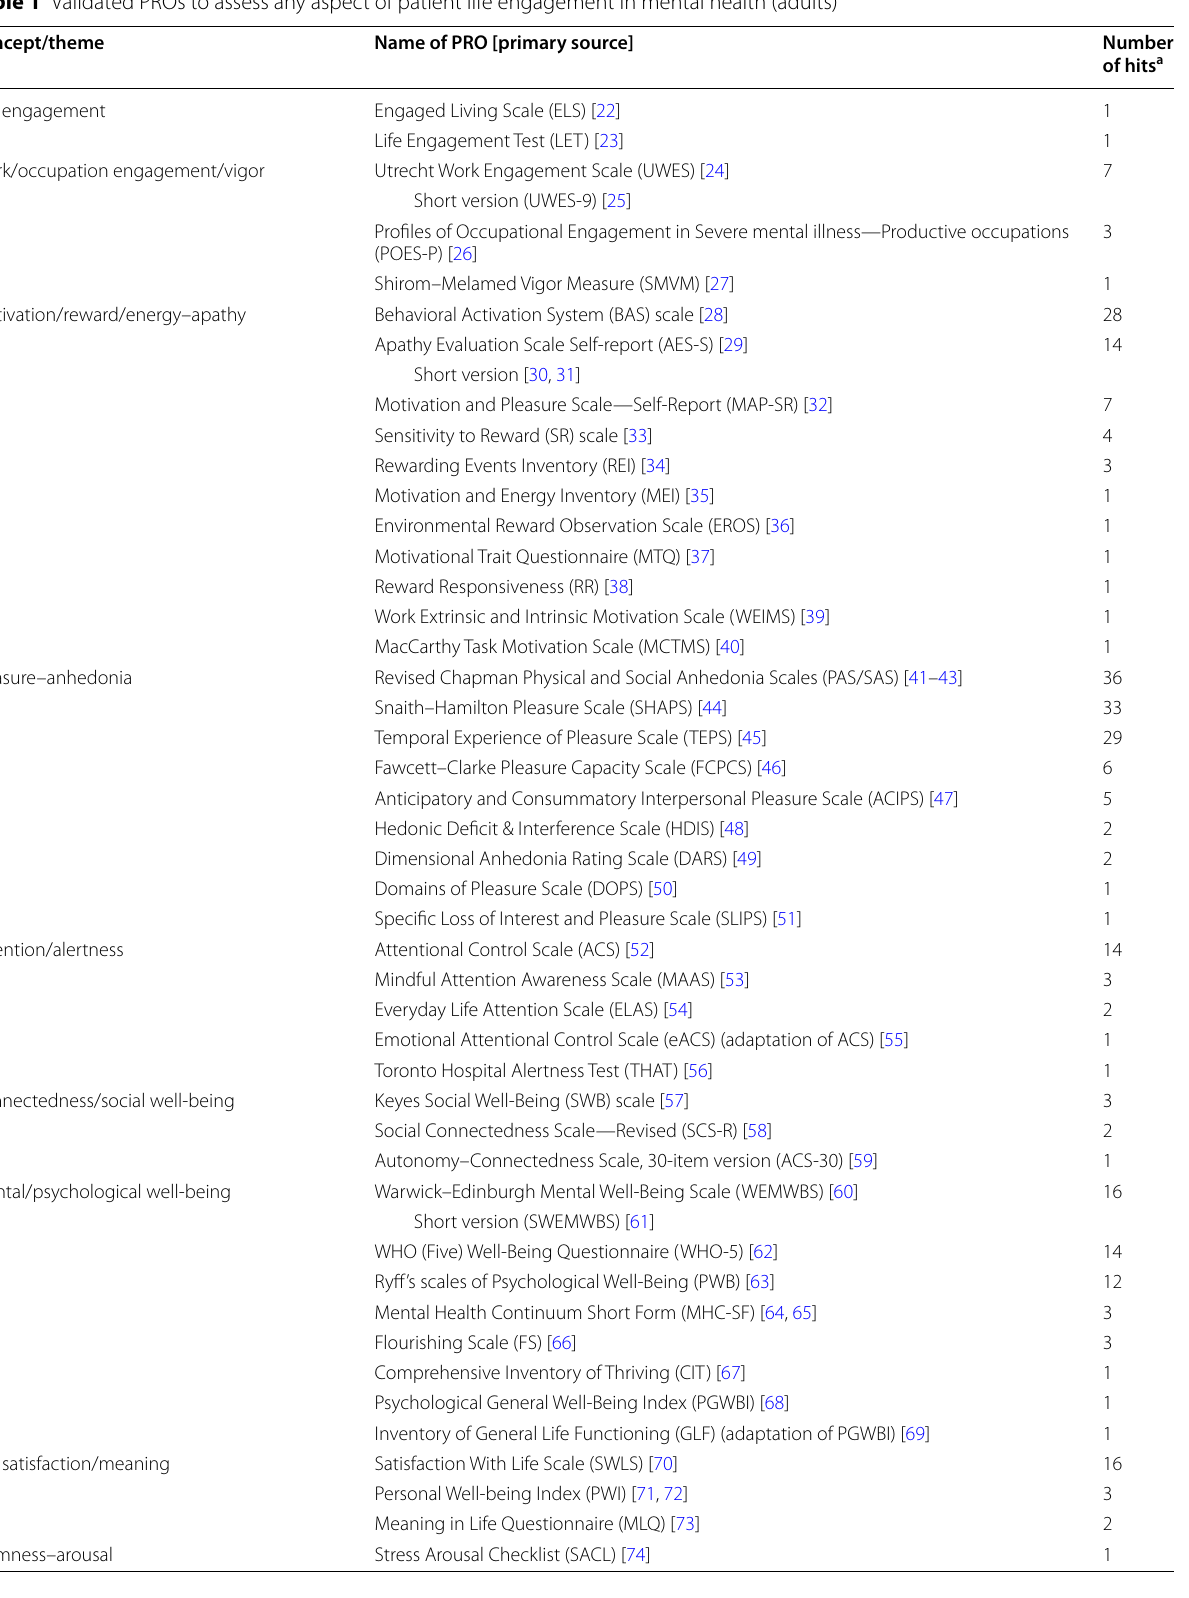
Table 1 Validated PROs to assess any aspect of patient life engagement in mental health (adults)